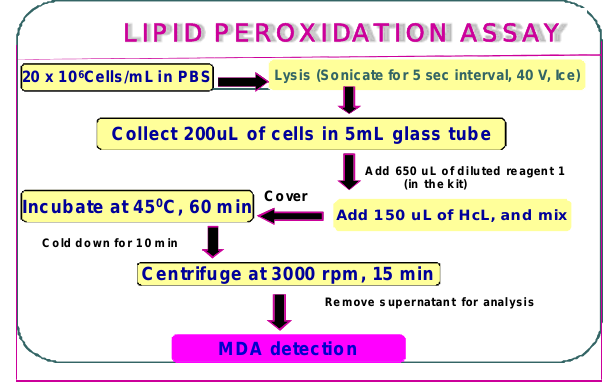
Figure 1: Schematic representation of the steps in lipid peroxidation assay